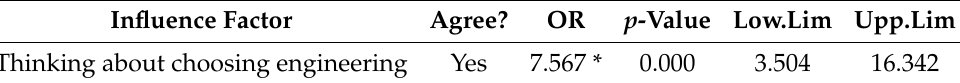
Table 3. Odds ratio, p -value and confidence interval obtained for the study of the advantage to answer “Yes” for boys in the question about if they think about choosing an engineering degree. An * indicates statistical significance.